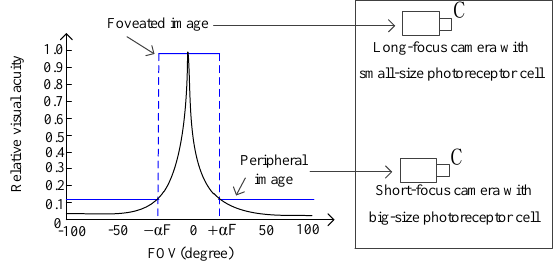
Figure 4. The designed two sub-optical systems.